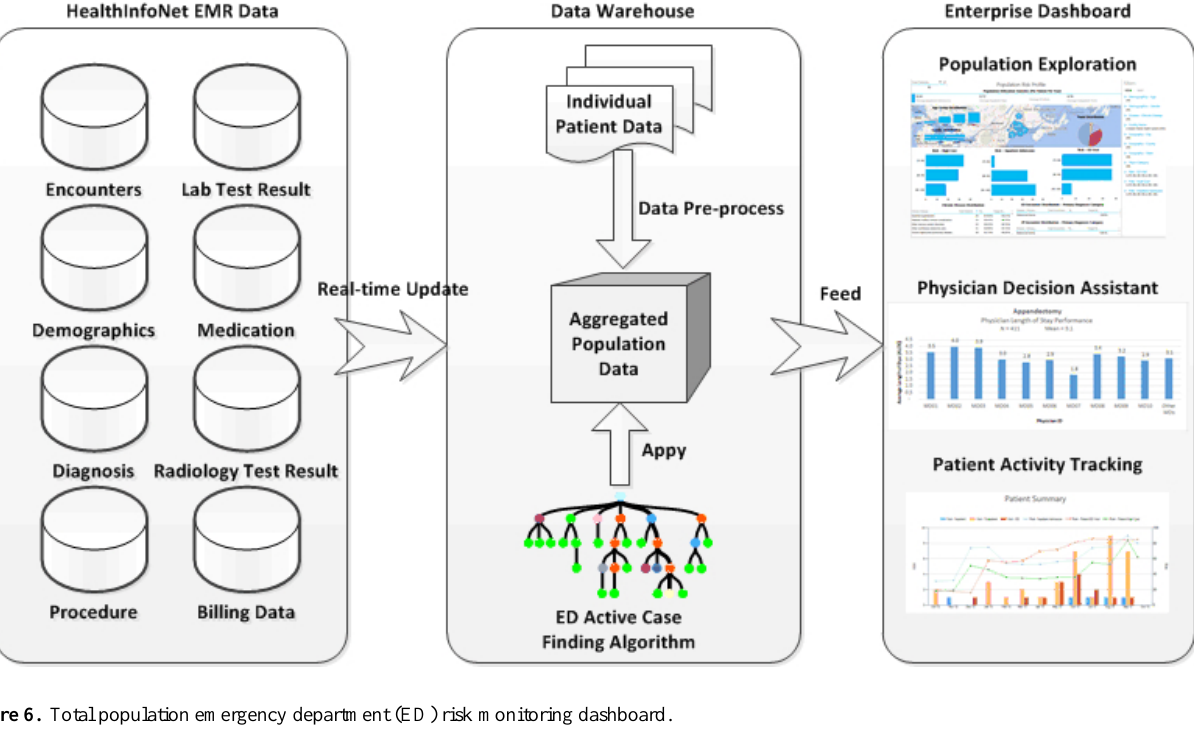
Figure 6. Total population emergency department (ED) risk monitoring